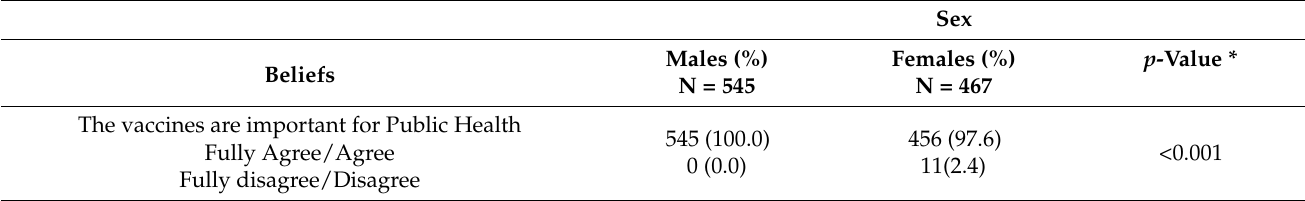
Table 3. Athletes’ beliefs on vaccines for SARS-CoV-2 by